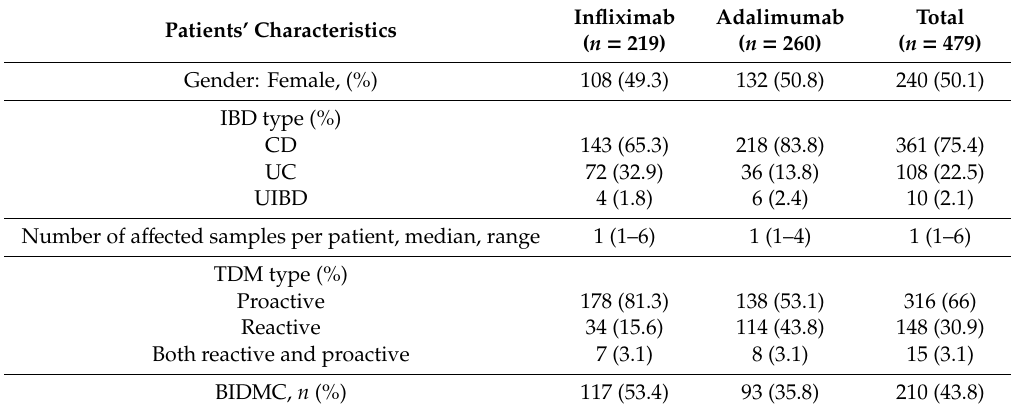
Table 1. Patients’ demographic and clinical characteristics. Patients’